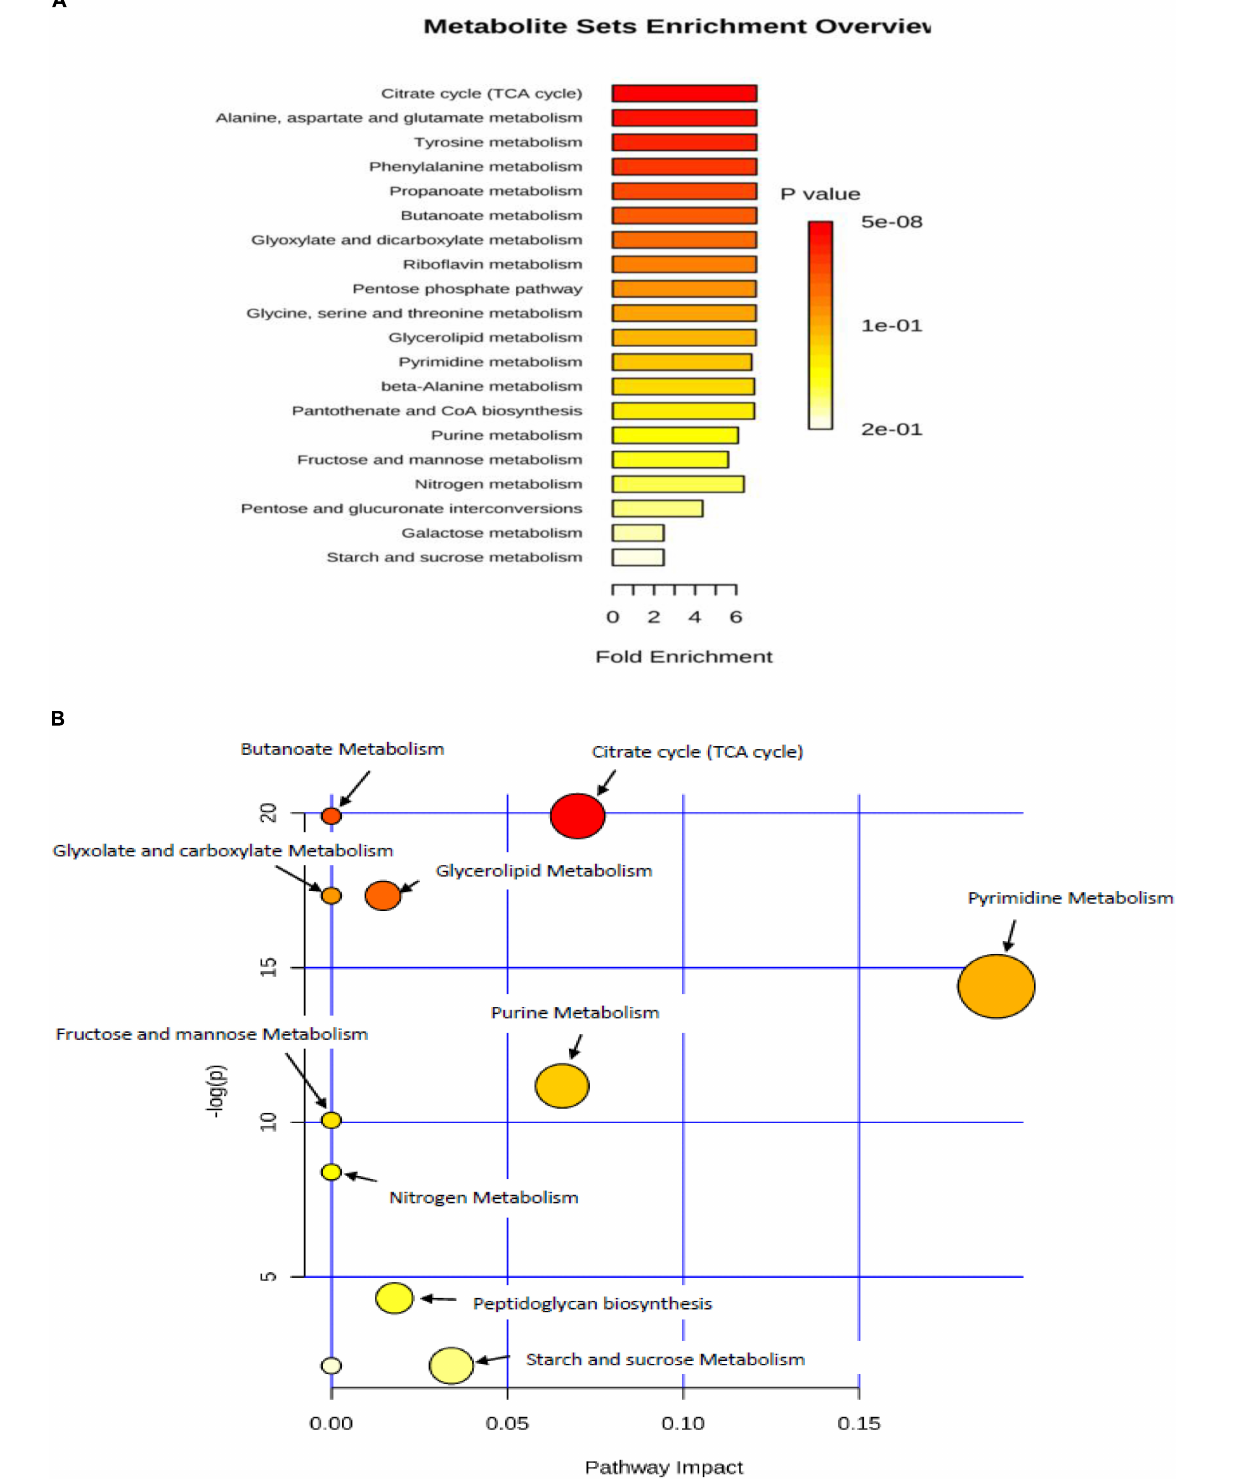
Frontiers in Microbiology |